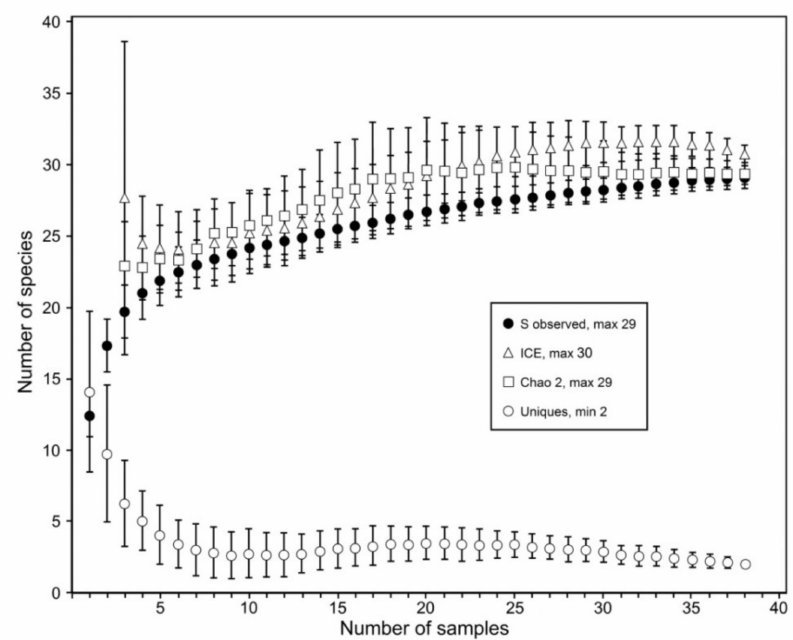
Figure 9. Species richness estimators covering 29 mushroom coral species observed in 38 reef sites based on incidence